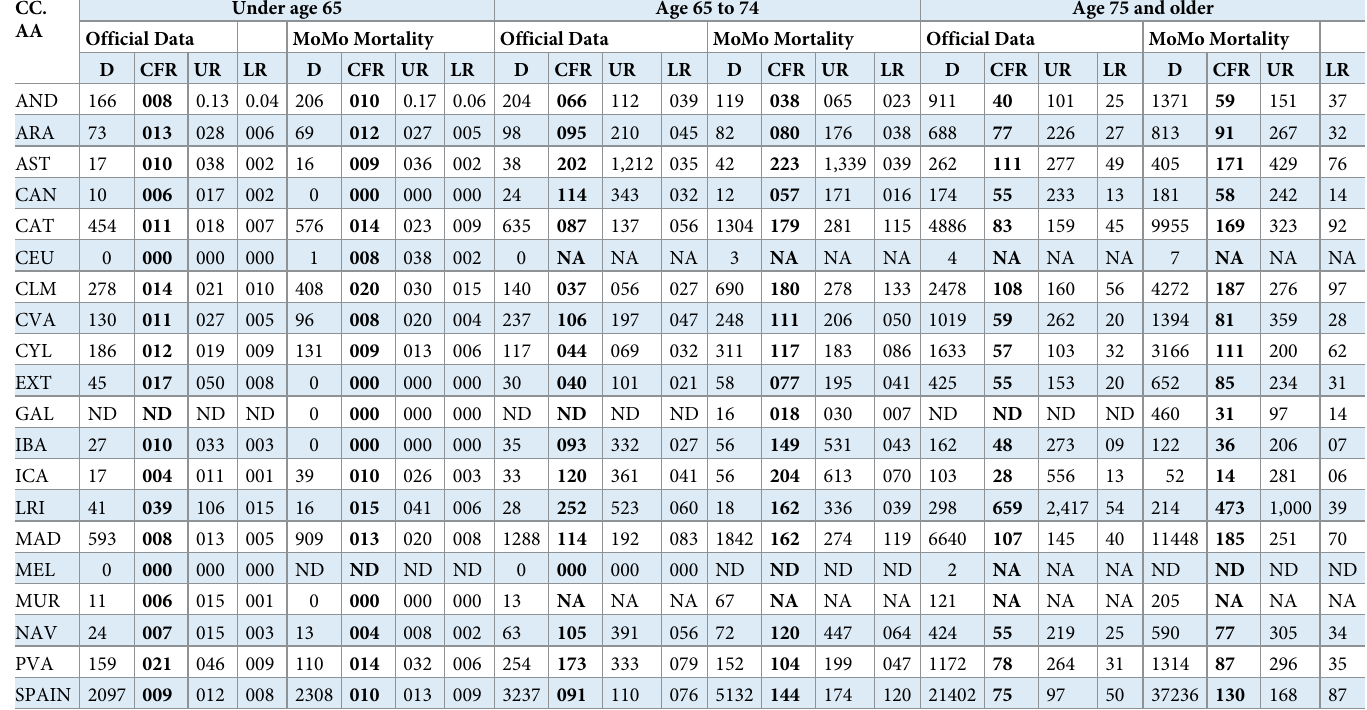
Table 3. Death figures and case fatality rates according to official data calculated according to excess mortality, by Autonomous Communities (CC.AA.) and age groups. CC. AA